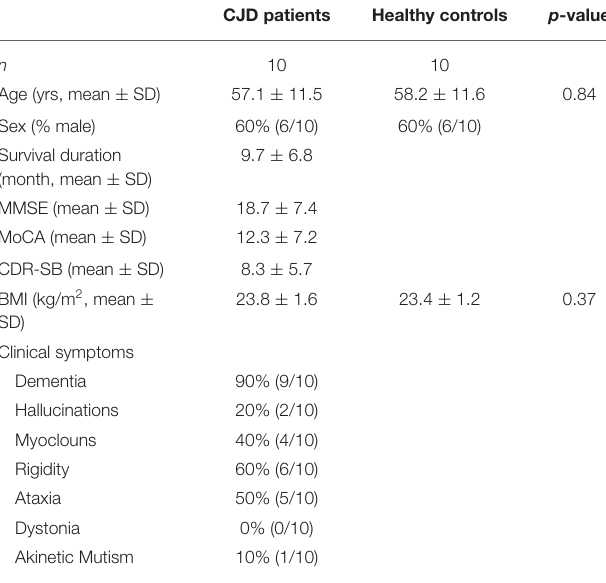
TABLE 1 | Summary of the